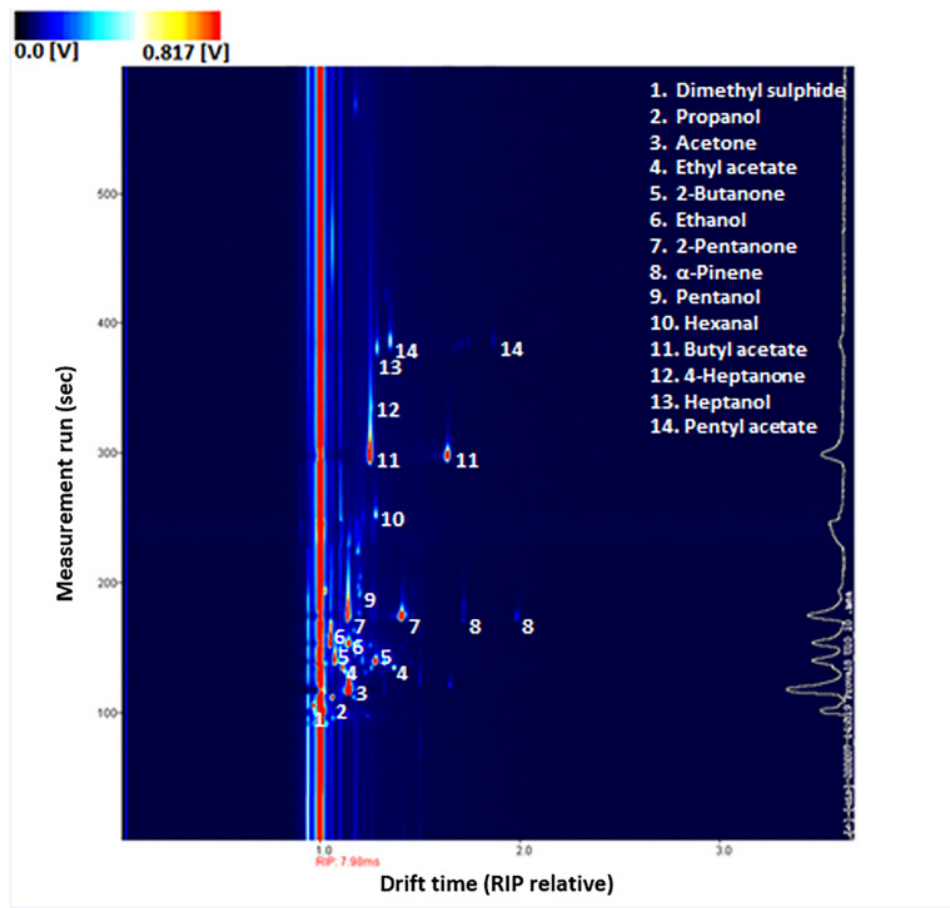
Figure 2. Example of GC–IMS spectrum of a urine sample. Detected VOCs have been highlighted. Increasing concentrations of VOCs are outlined by the colour change from blue to red.